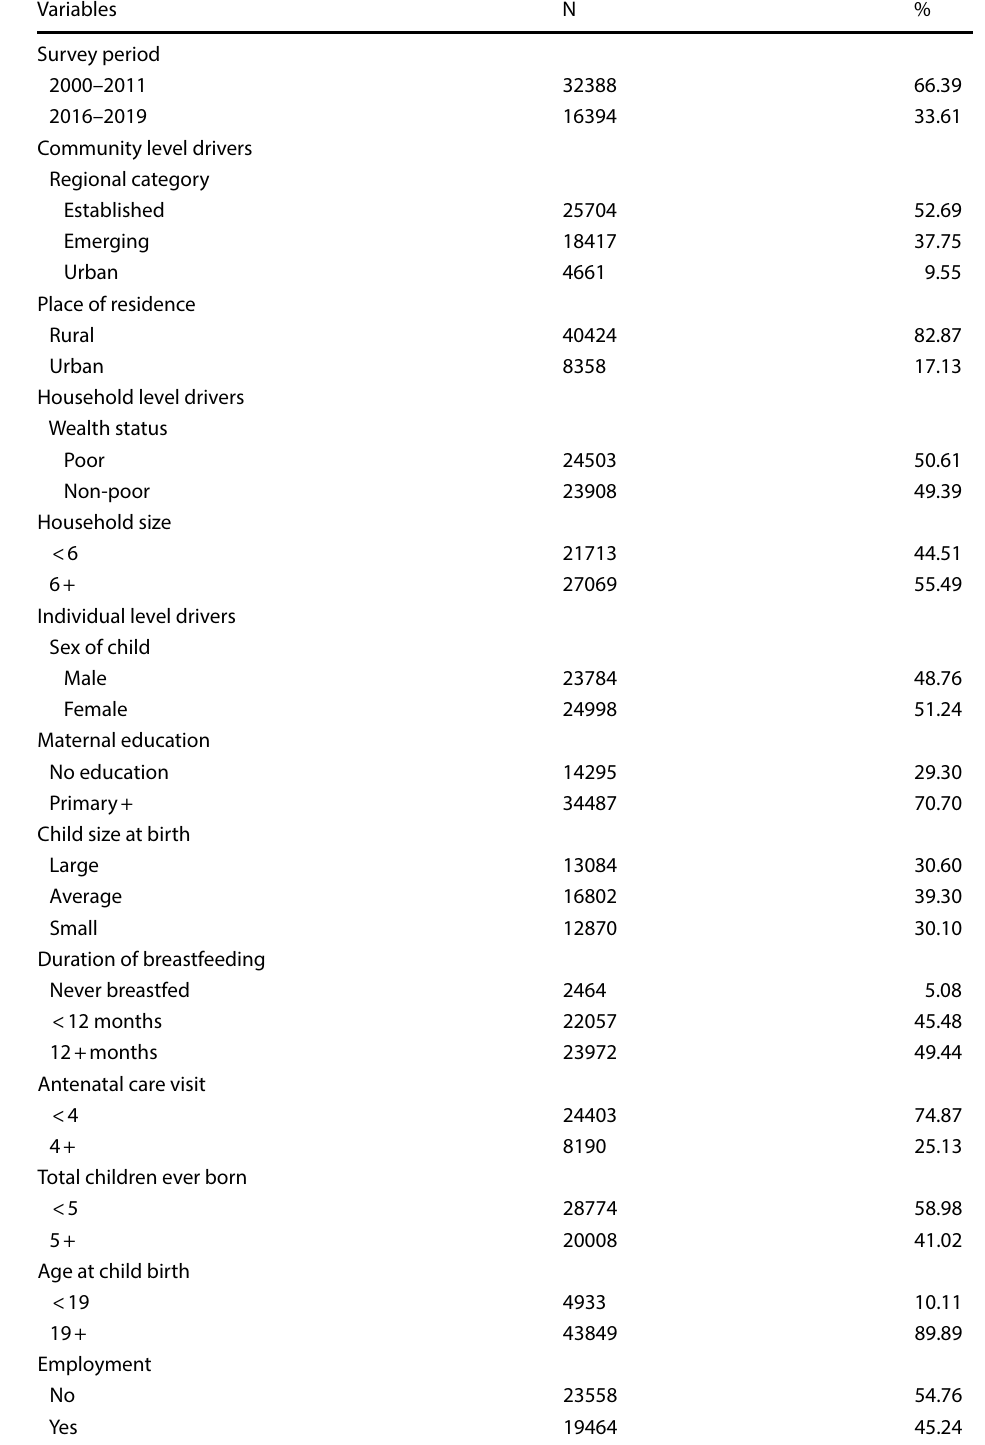
Table 1 Background characteristics of the study participants (N = 48,782), Ethiopia,